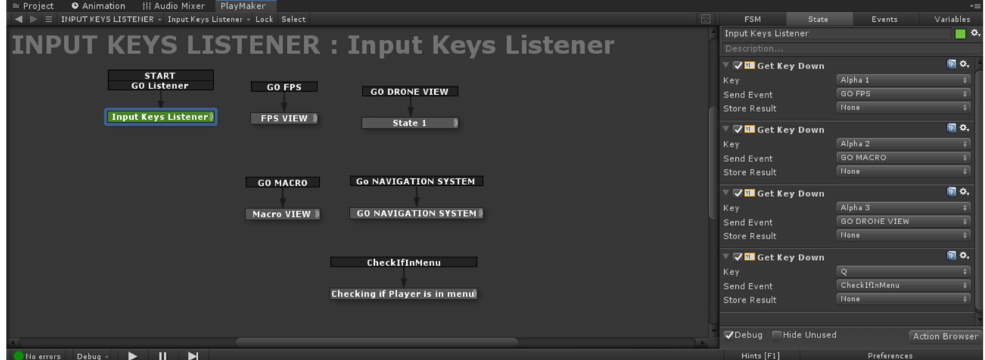
Figure 6. Playmaker—Visual Scripting Tool (User Interface